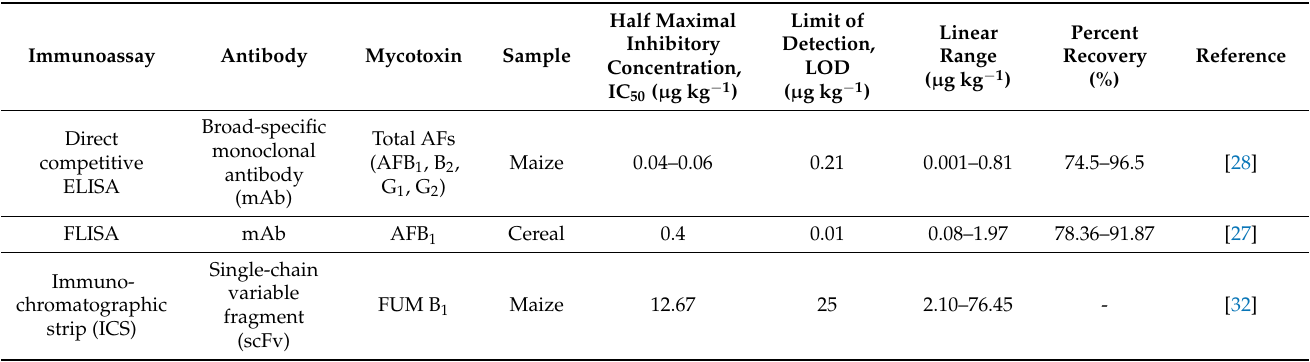
Table 1. Application of antibodies for mycotoxin detection in food